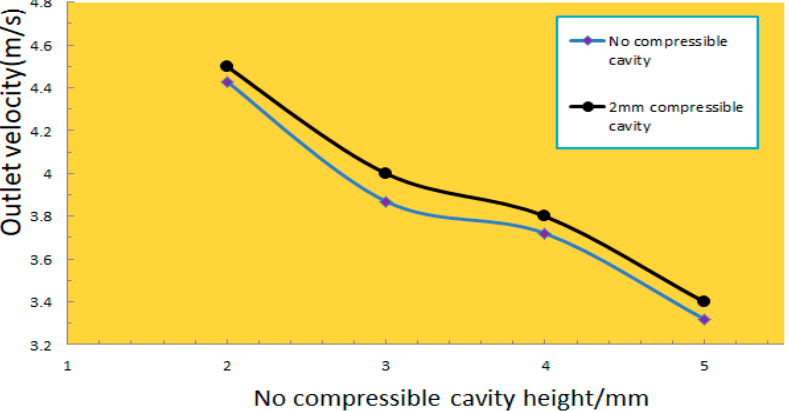
Figure 3. The flow rate curve at the outlet with a 2 mm compressible cavity at the inlet and an in- compressible cavity at the outlet.